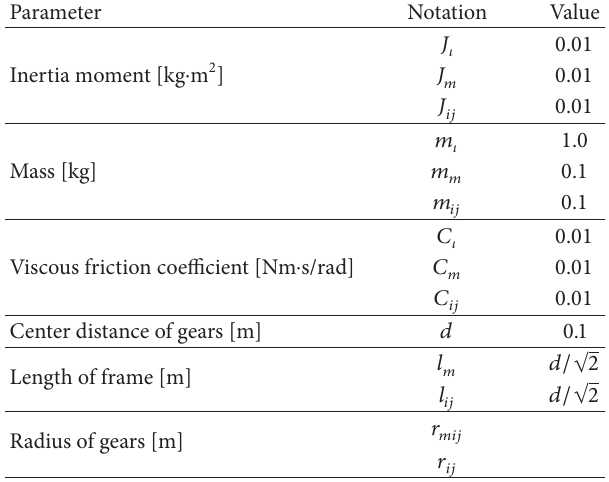
Figure 3: Schematic diagram of the constraint-free model. In this system, all gravity centers have the highest degree of freedom.